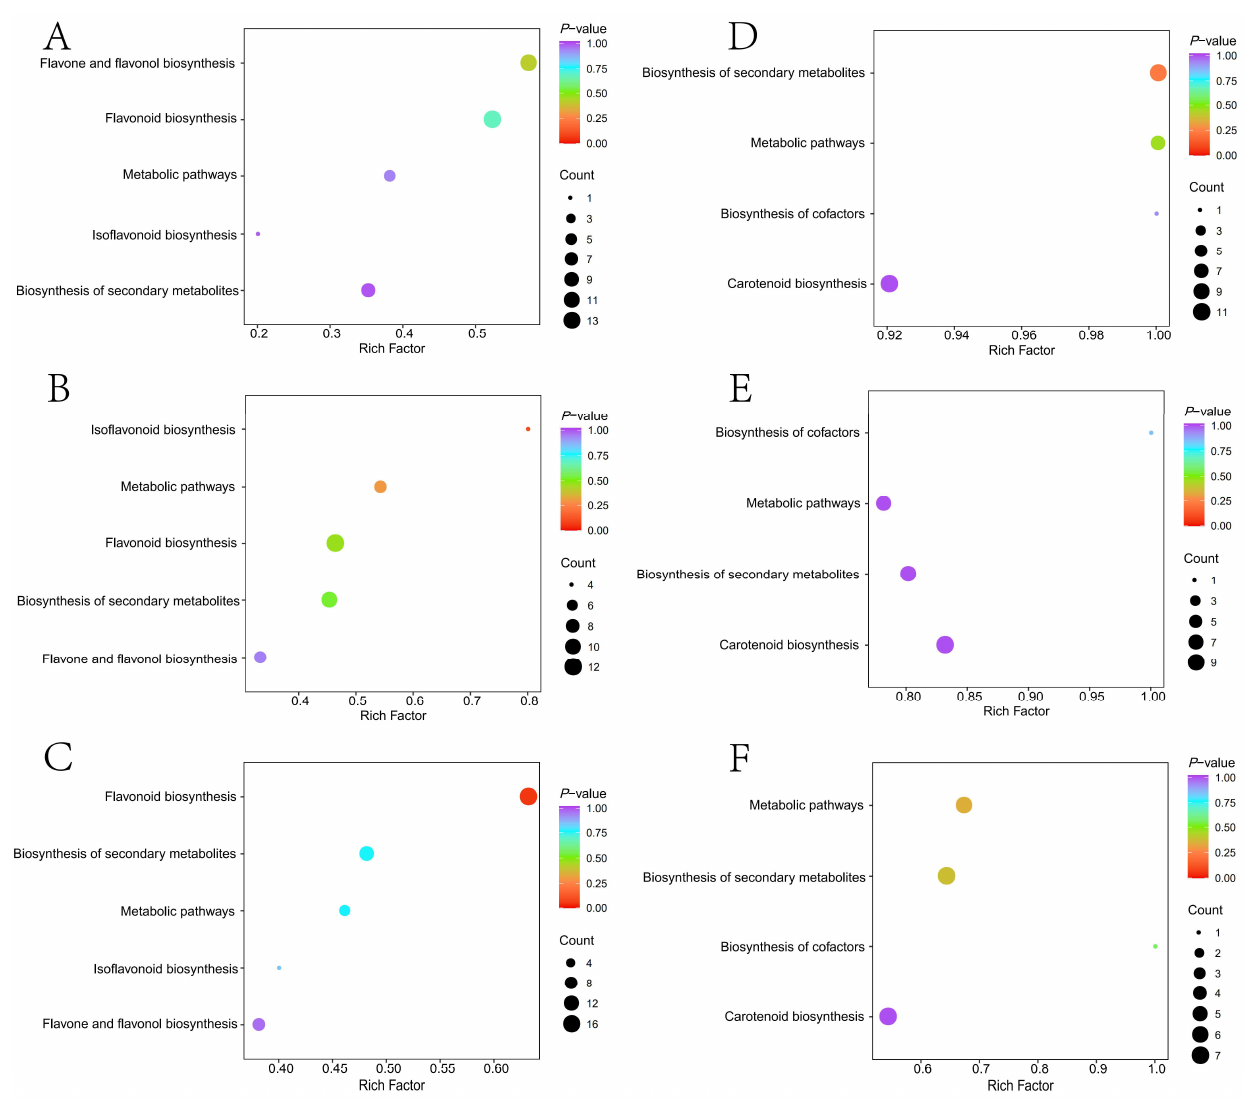
Figure 3. Metabolite analysis. ( A – C ) Differential metabolite enrichment pathways of flavonoids in CbW-vs-CbY, CbY-vs-CbO, and CbO-vs-CbR.; ( D – F ) Differential metabolite enrichment pathways for carotenoids in CbW-vs-CbY, CbY-vs-CbO, and CbO-vs-CbR. Note: The horizontal coordinate indicates the corresponding rich factor for each pathway, the vertical coordinate is the pathway name, and the color of the dots is p -Value, with more red indicating more significant enrichment. The size of the dots represents the number of differential metabolites enriched.